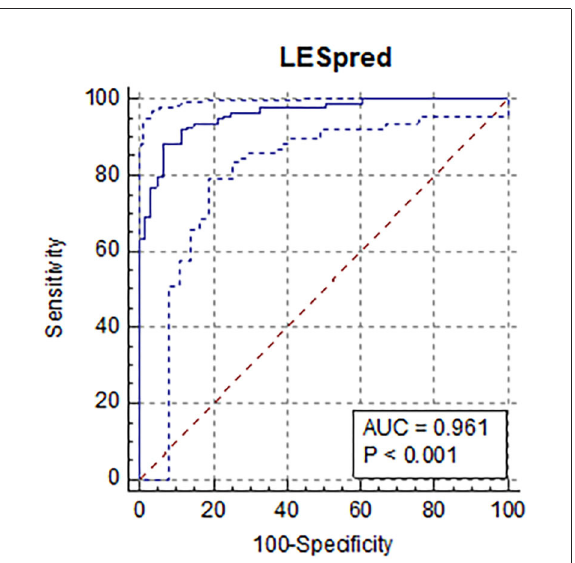
FIGURE2 Results of the receiver operator curve (ROC) for the results of the prediction equation showing an area under the curve of 96% (AUC = 0.961; 95% CI: 0.55–0.69; positive likelihood ratio = 13.5) using an optimal cut-off value of 0.61, sensitivity was 88.6%, and specificity was 93.4%. All the variables included were statistically significant.